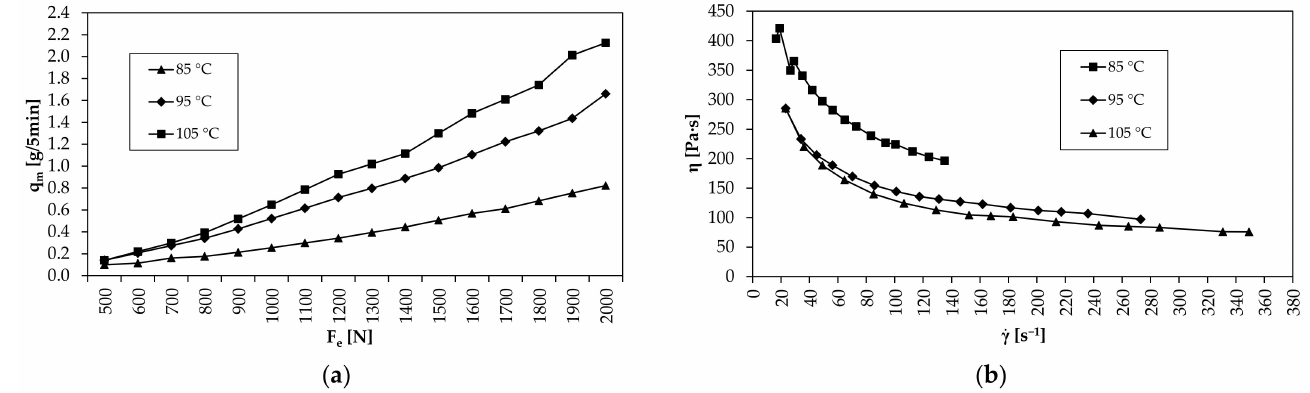
Figure 10. ( a ) Experimentally determined mass flows for tested force and temperature interval; ( b ) viscosity curves showing pseudoplastic flow behavior for tested extrusion temperature